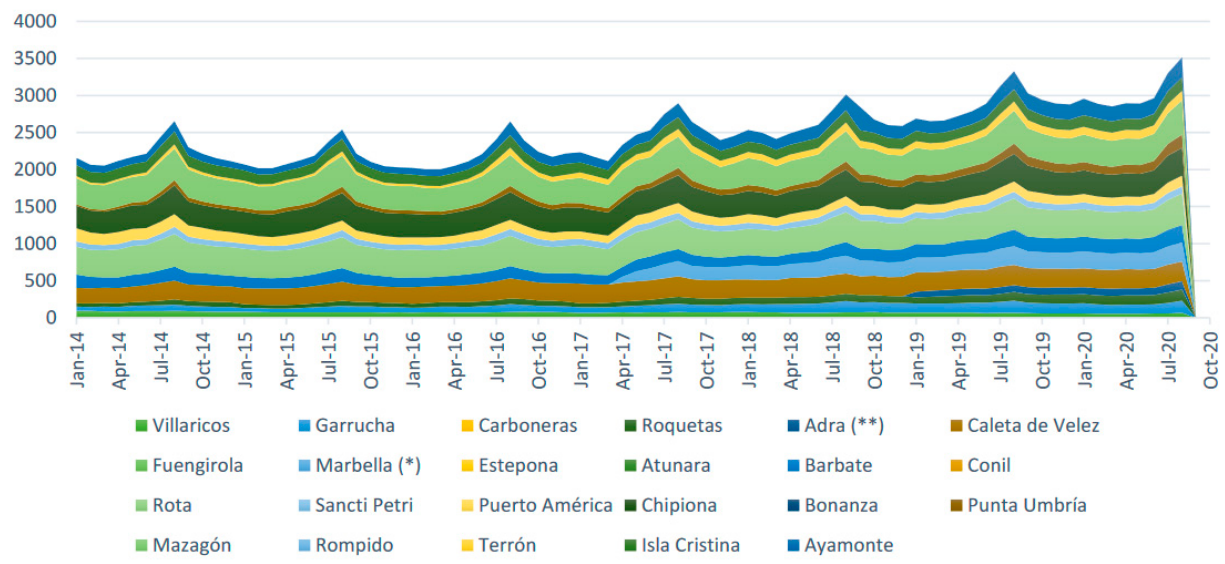
Figure 1. Occupancy of some marinas in Andalusia (2014–2020). Source: APPA,